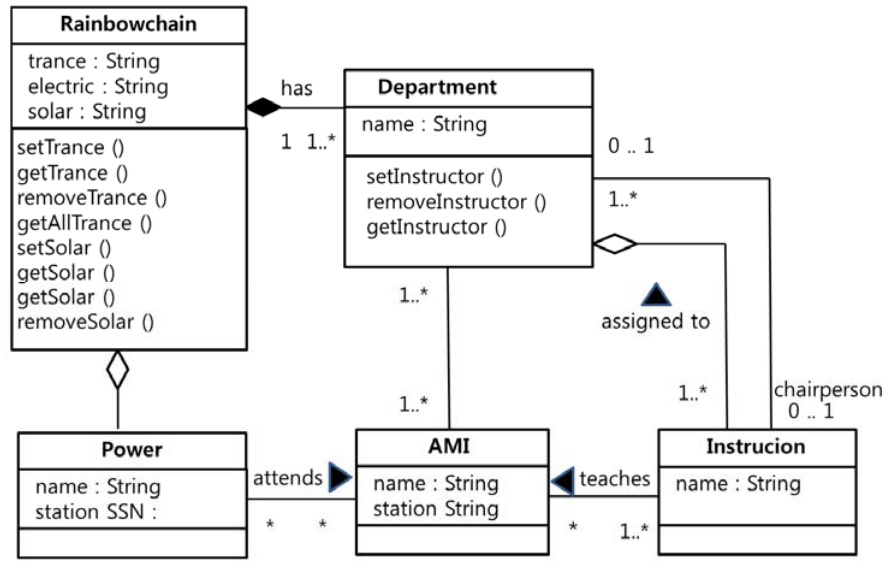
Figure 7. Rainbowchain class diagram. *: routine. Energies 2018 , 17 , x FOR PEER REVIEW